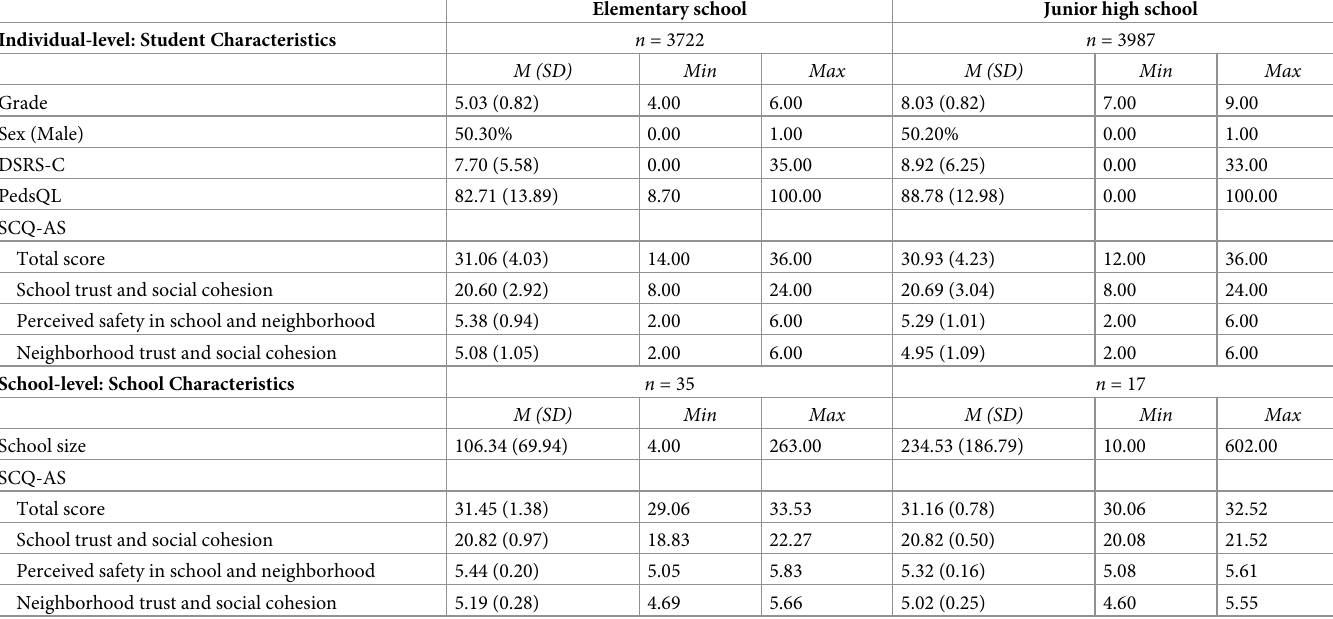
Table 1. Descriptive